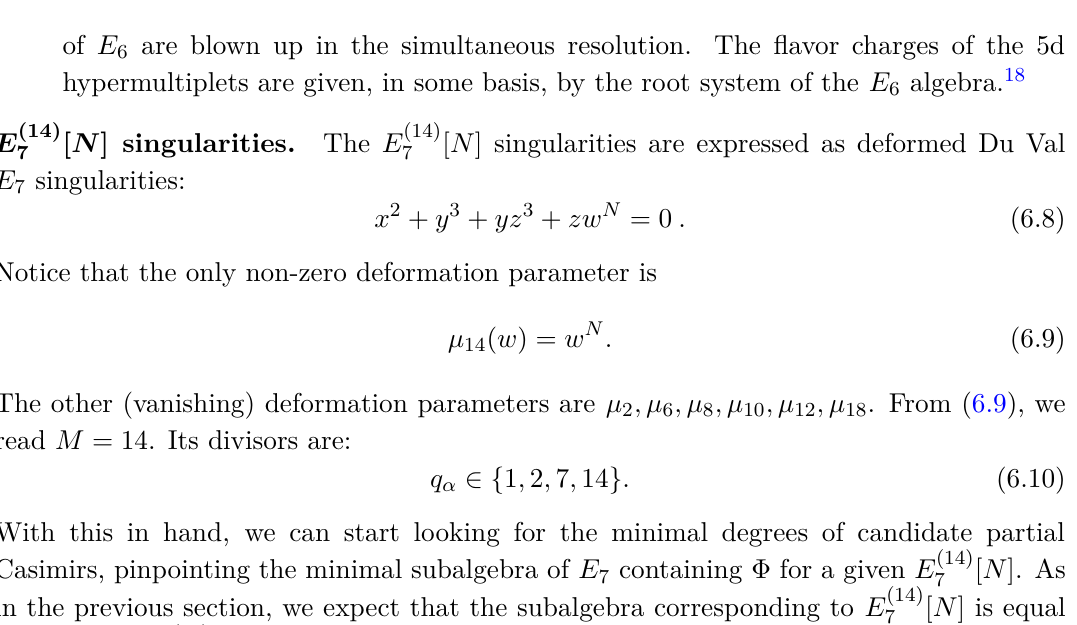
Figure 11 . A 6 subalgebra in the N = 2 , 4 , 6 , 8 , 10 , 12